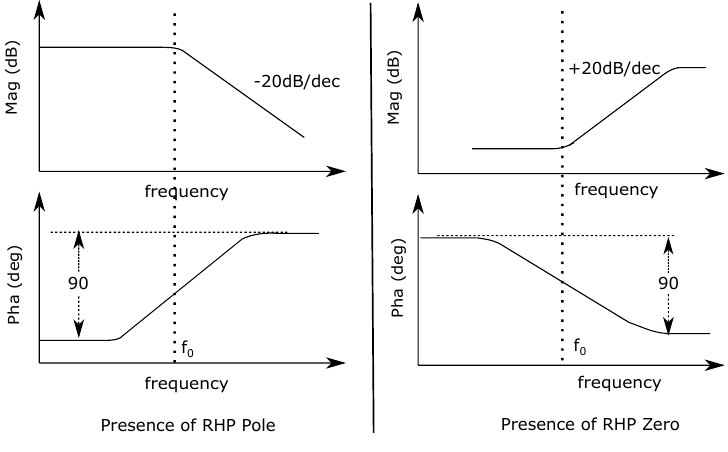
Figure 4. Frequency response of RHP poles and zeroes.